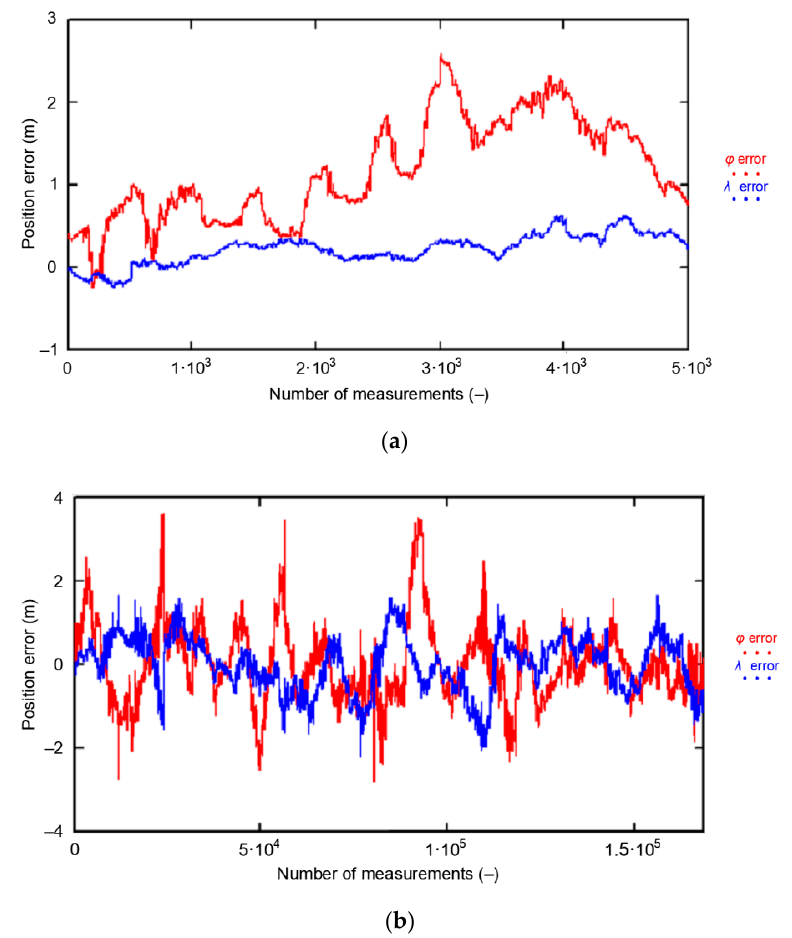
Figure 10. GPS position error for ( a ) 5000; ( b ) 168’286 fixes during the GPS measurement campaign in